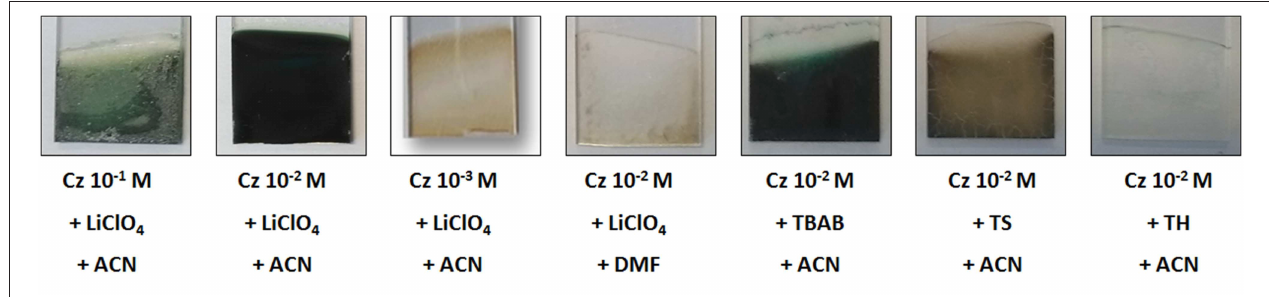
FIGURE 2 | Photographs of samples obtained by oxidation of carbazole at different concentrations and in electrolytes containing different solvents and supporting salts.